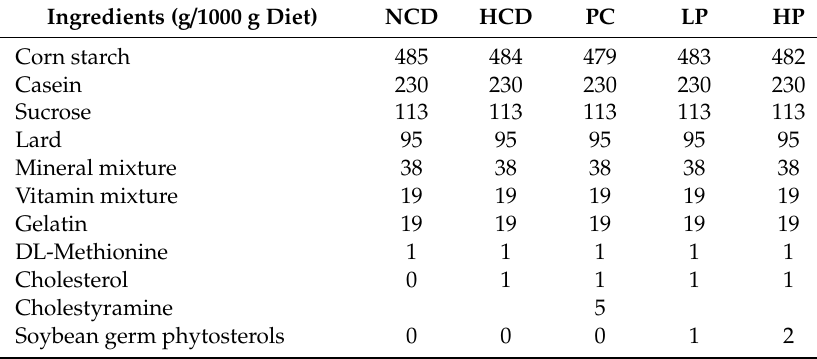
Table 1. Composition of the five diets. NCD, no cholesterol diet; HCD, high cholesterol diet containing 0.1% cholesterol; PC, high cholesterol diet containing 0.5% cholestyramine; LP, high cholesterol